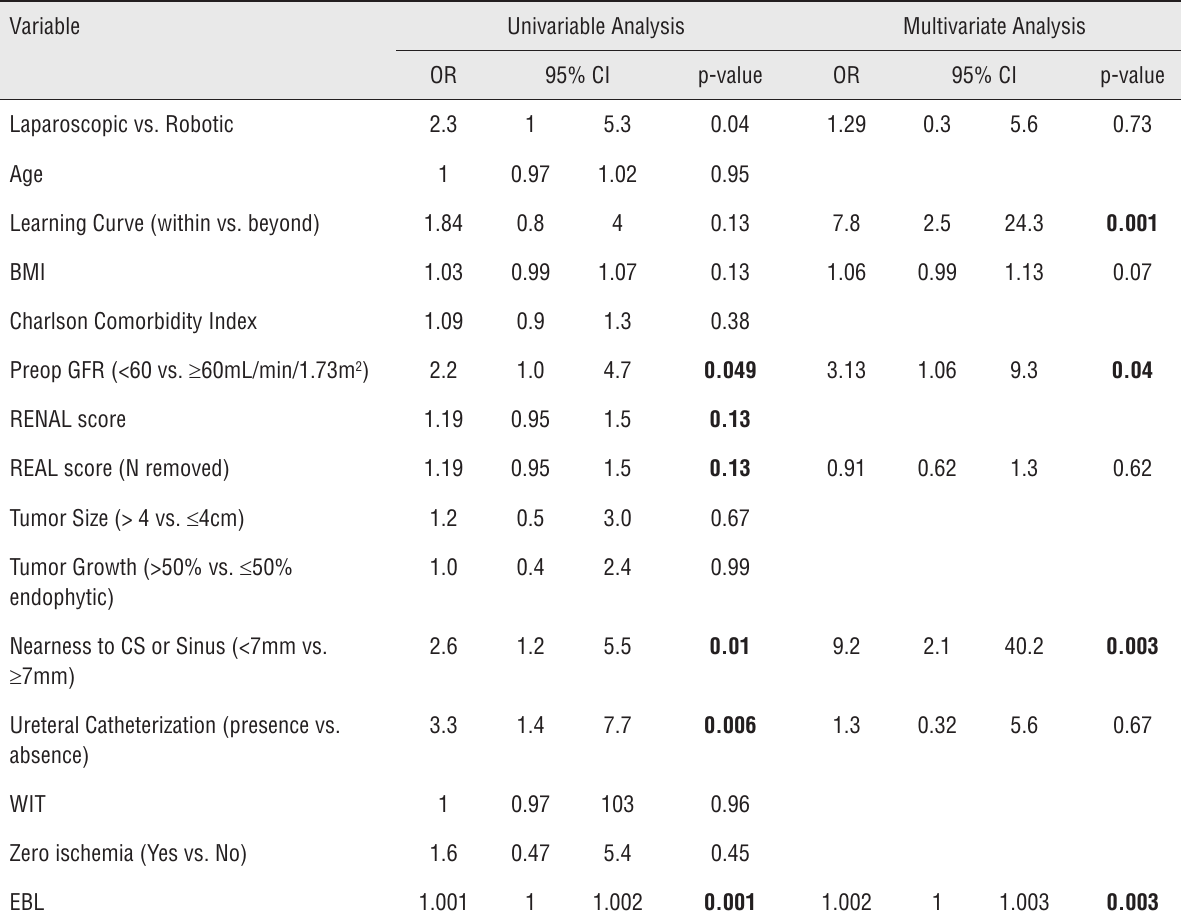
Table 4 - Univariable and Multivariable Analysis of factors predicting postoperative urine leak. Variable OR 95% CI p-value OR 95% CI p-value Laparoscopic vs. Robotic